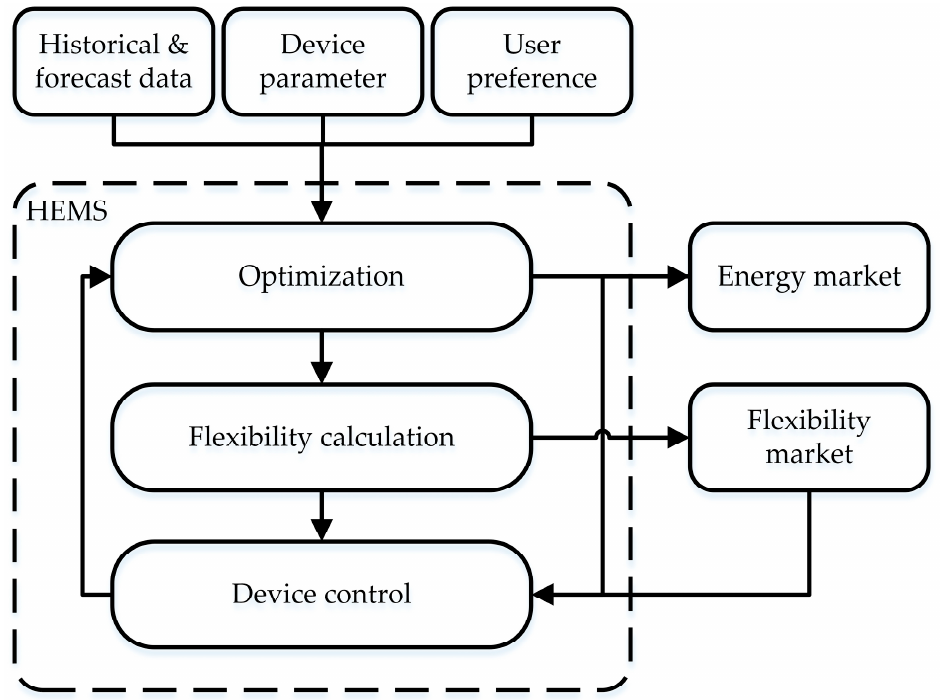
Figure 1. Generalized structure of an HEMS. Historical and forecast data refers to weather data, historical consumption and production data and expected energy prices.